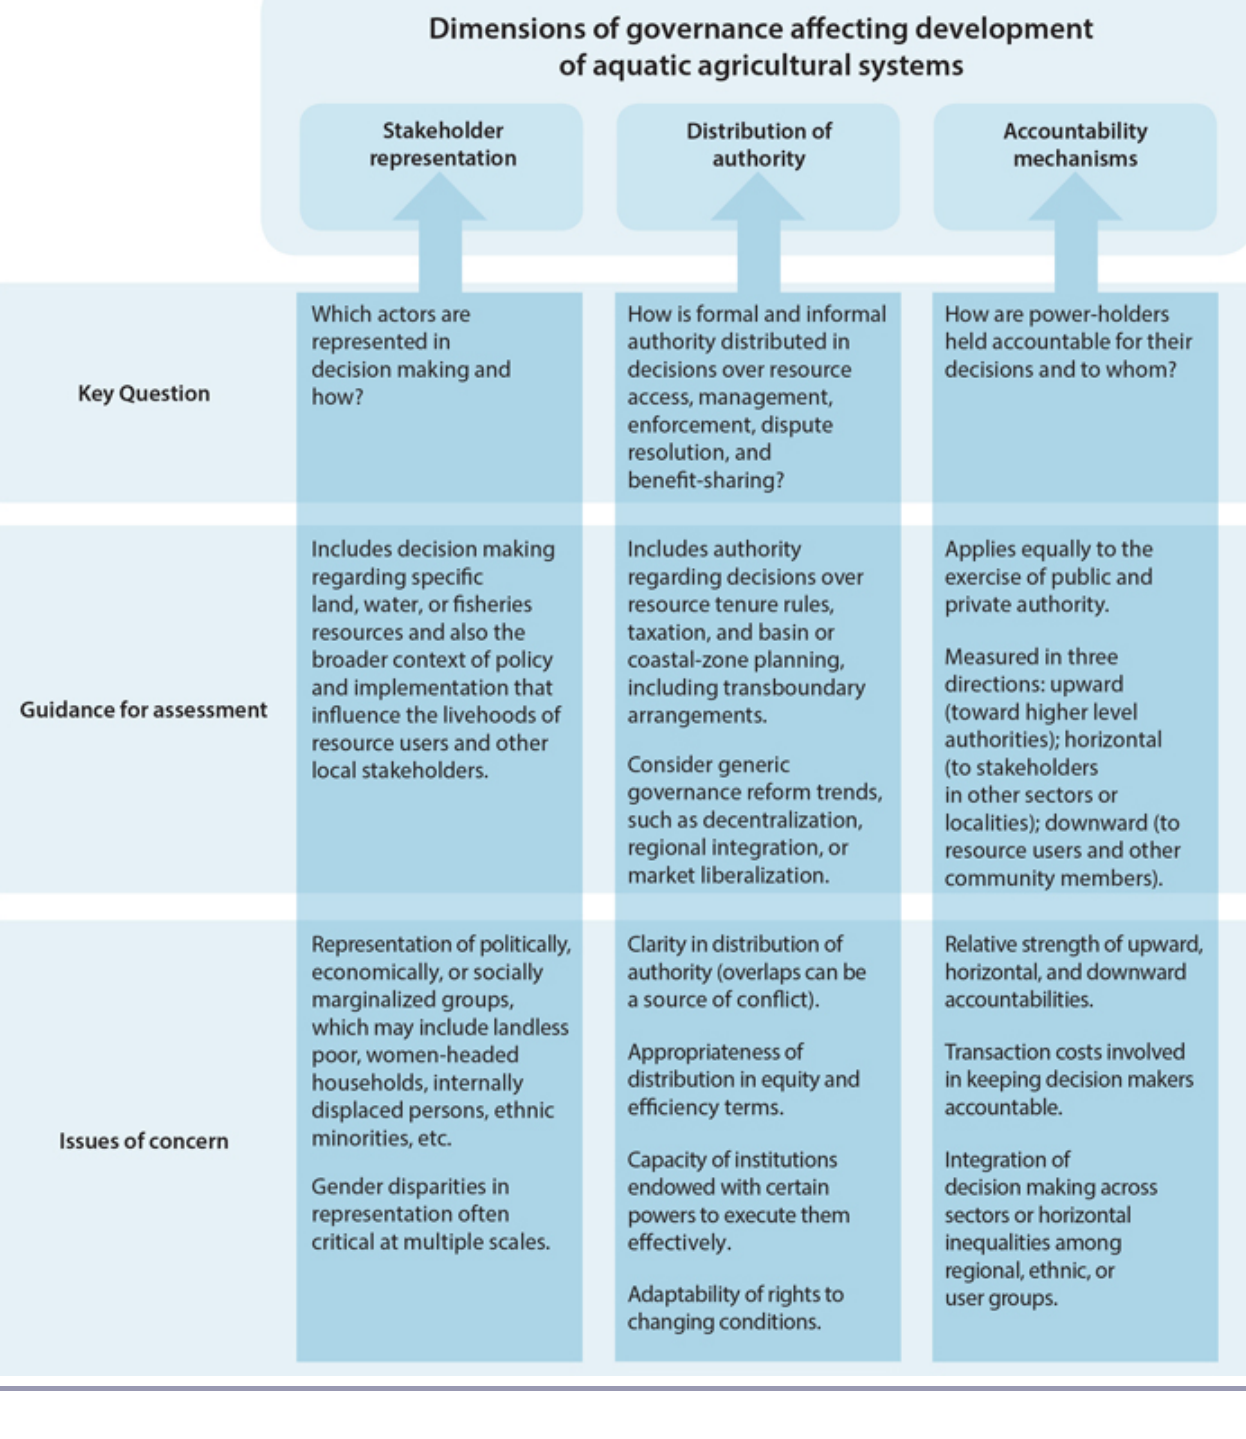
Fig. 1 . Key questions and considerations in analyzing the governance context for development of aquatic agricultural